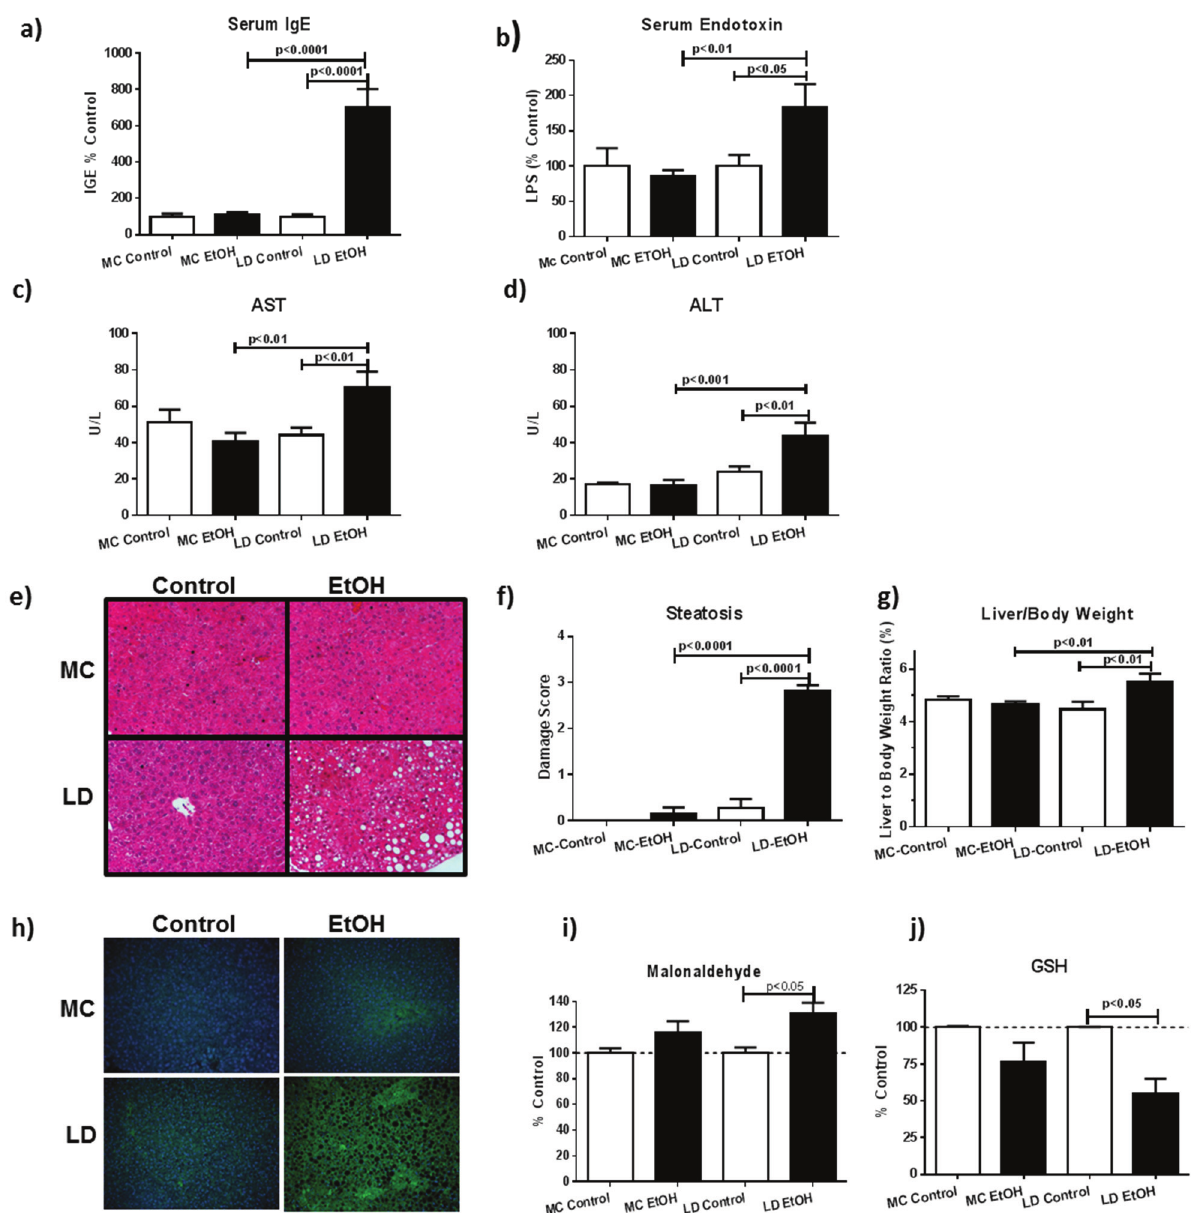
Figure 1. LD EtOH feeding causes greater steatohepatitis and oxidative damage than MC EtOH feeding. Mice were fed alcohol using MC or LD diets. ( a ) Non-antigen specific IgE is increased only after LD EtOH ingestion; ( b ) serum endotoxin levels are elevated only after LD EtOH exposure ( n = 7–10); ( c ) serum AST and ( d ) ALT are elevated after LD but not MC EtOH exposure ( n = 6). Livers were weighed and histological sections examined for visual changes due to the feeding models. Representative liver sections stained with H & E ( e ) demonstrate quantitatively more steatosis with LD than MC feeding ( f ) ( n = 7–11); ( g ) liver weights as % of total body weight are increased after LD EtOH feeding ( n = 7–13) and lipid peroxidation (4-hydroxynoneal staining) ( h ) is elevated as evidenced by immunofluorescence; ( i ) TBAR assay confirms elevated malonaldehyde in liver homogenates ( n = 3–8); and ( j ) the antioxidant GSH is significantly depleted after LD diet ( n =